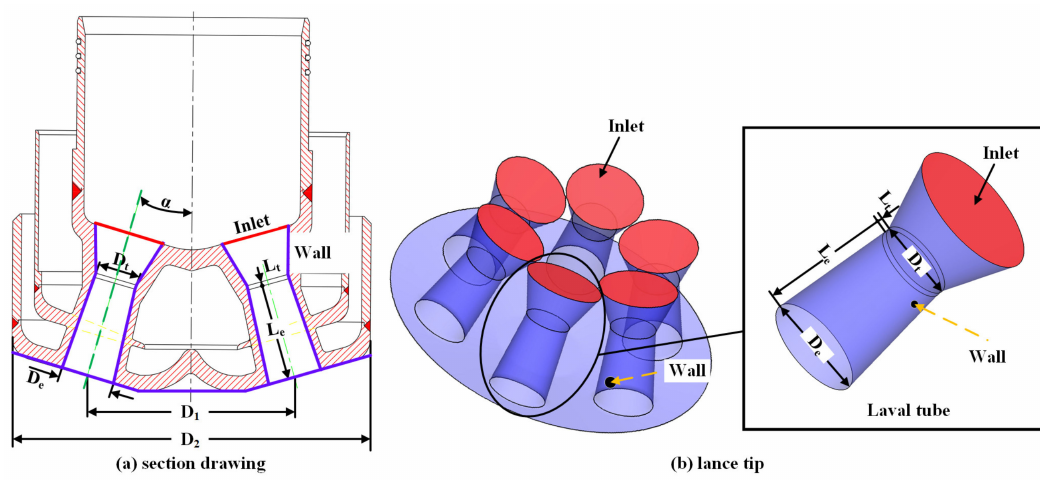
Figure 2. Structure of the ( a ) cross-sectional drawing of the lance tip. ( b ) Lance